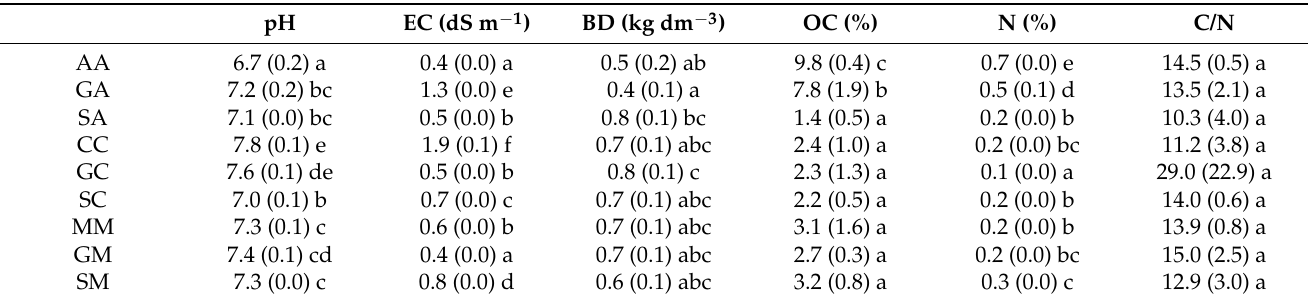
Table 4. Mean values of the soil properties analyzed at the end of the